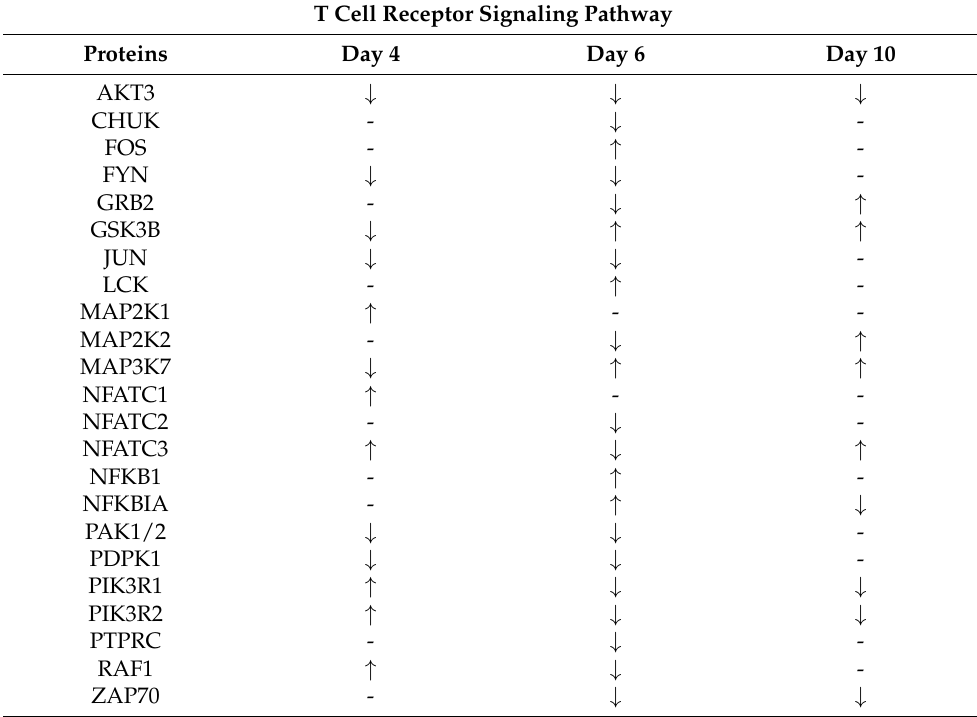
Table 4. T-cell receptor signaling pathway in chicken ceca on days 4, 6, and 10 of age. The results of this table indicate no clear path utilized by the host immunity of the T-cell receptor signaling